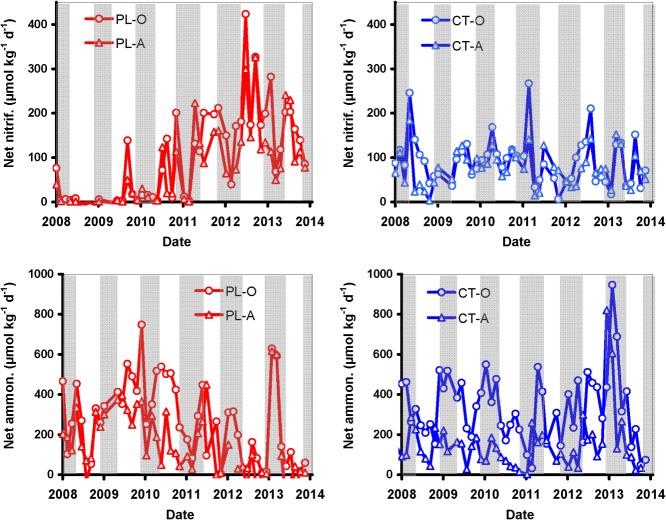
Temporal variability in net nitrification and net ammonification in the O and A soil horizons at the Plešné (PL) and Čertovo (CT) plots during the period 2008–2013.
Grey fields represent periods with snow cover. Temporal variability of other soil parameters is shown in S1 and S2 and S3 Figs.